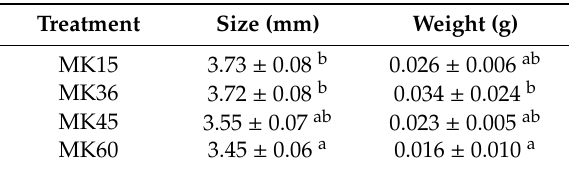
Table 2. Size and weight of makhwaen fruits.